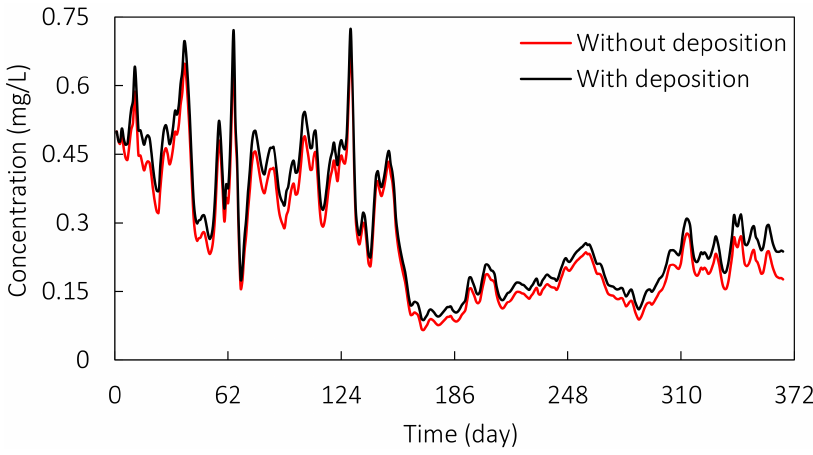
Figure 6. The simulated concentration of TN at the outlet of the middle route.